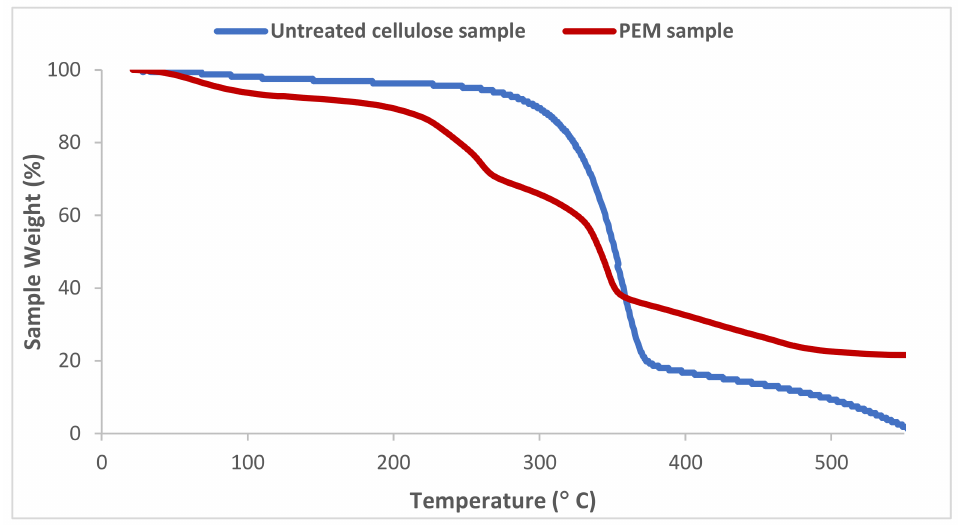
Figure 5. TGA thermograms of untreated cellulosic sample and PEM functionalized bio-sorbent